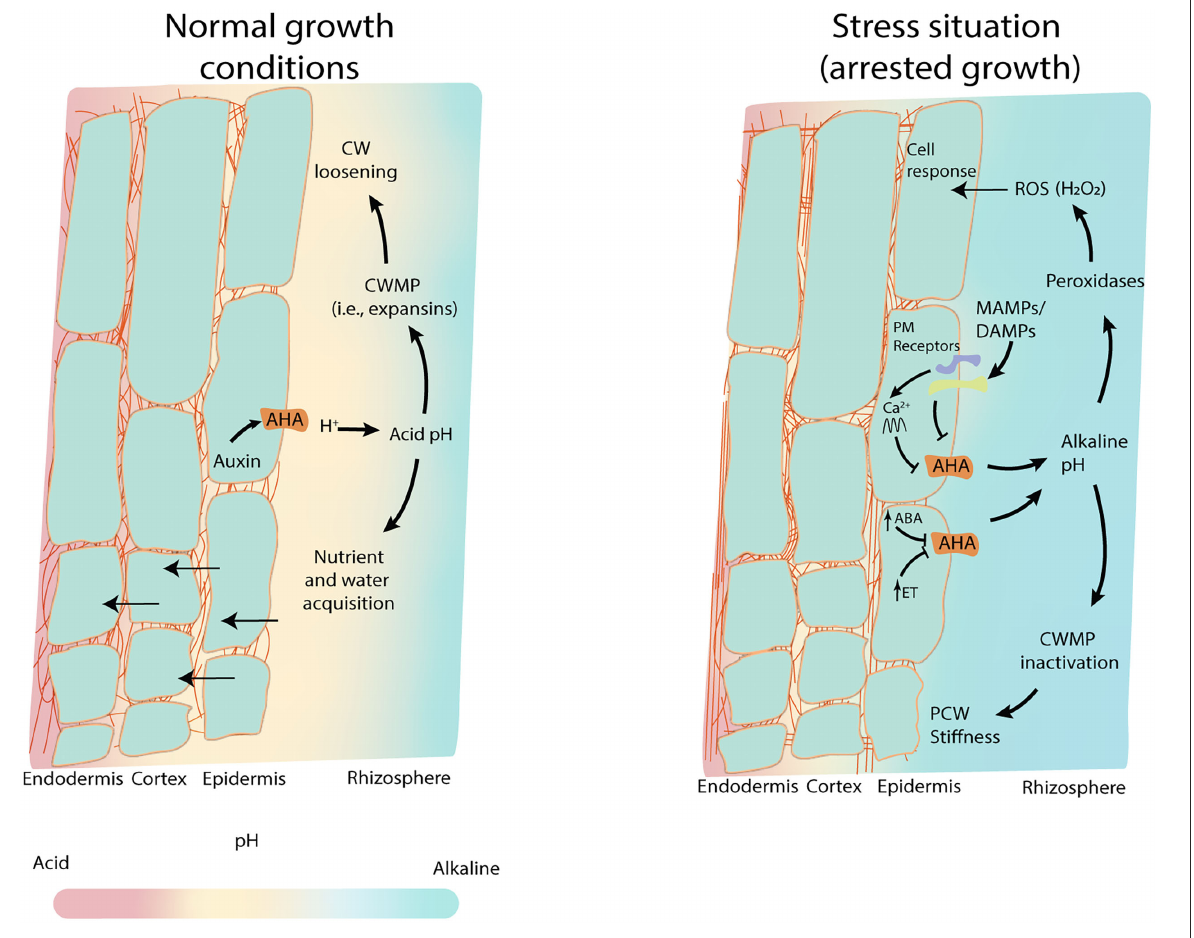
FIGURE1 pH apo as the hub for root response. pH apo forms a gradient along the rhizosphere and the different root cell layers, that favors nutrient and water uptake. In normal root growth conditions (left panel), low concentrations of auxin promote plasma proton pumps (AHA) activation lowering the pH apo which induces CW loosening and vacuole regulation for water uptake. This, together with nutrient uptake, boosts cell growth (acid growth theory) . Acid pH induces the activation of CW modifying proteins (CWMPs) such as expansins, to promote the CW loosening easing